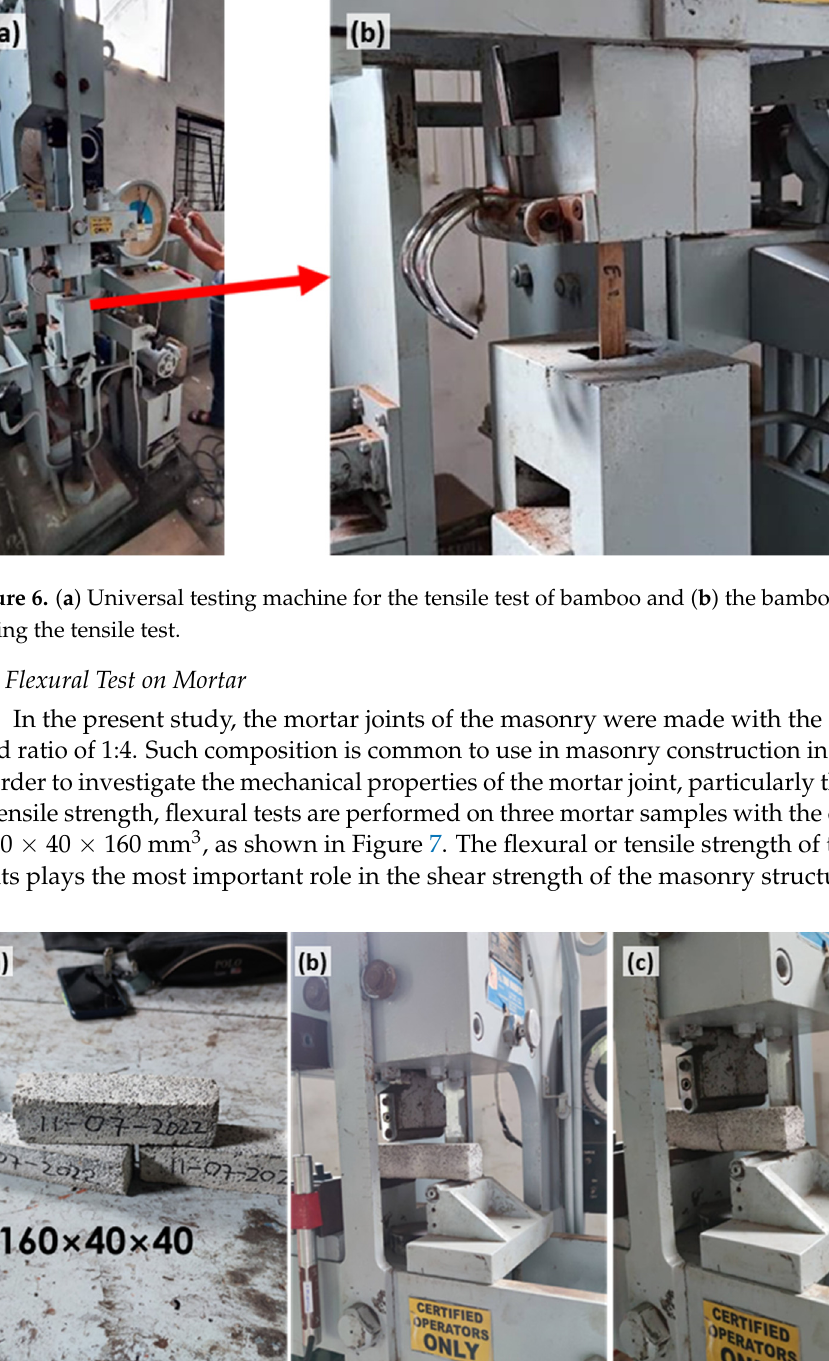
Figure 5. Bamboo specimens for tensile test.